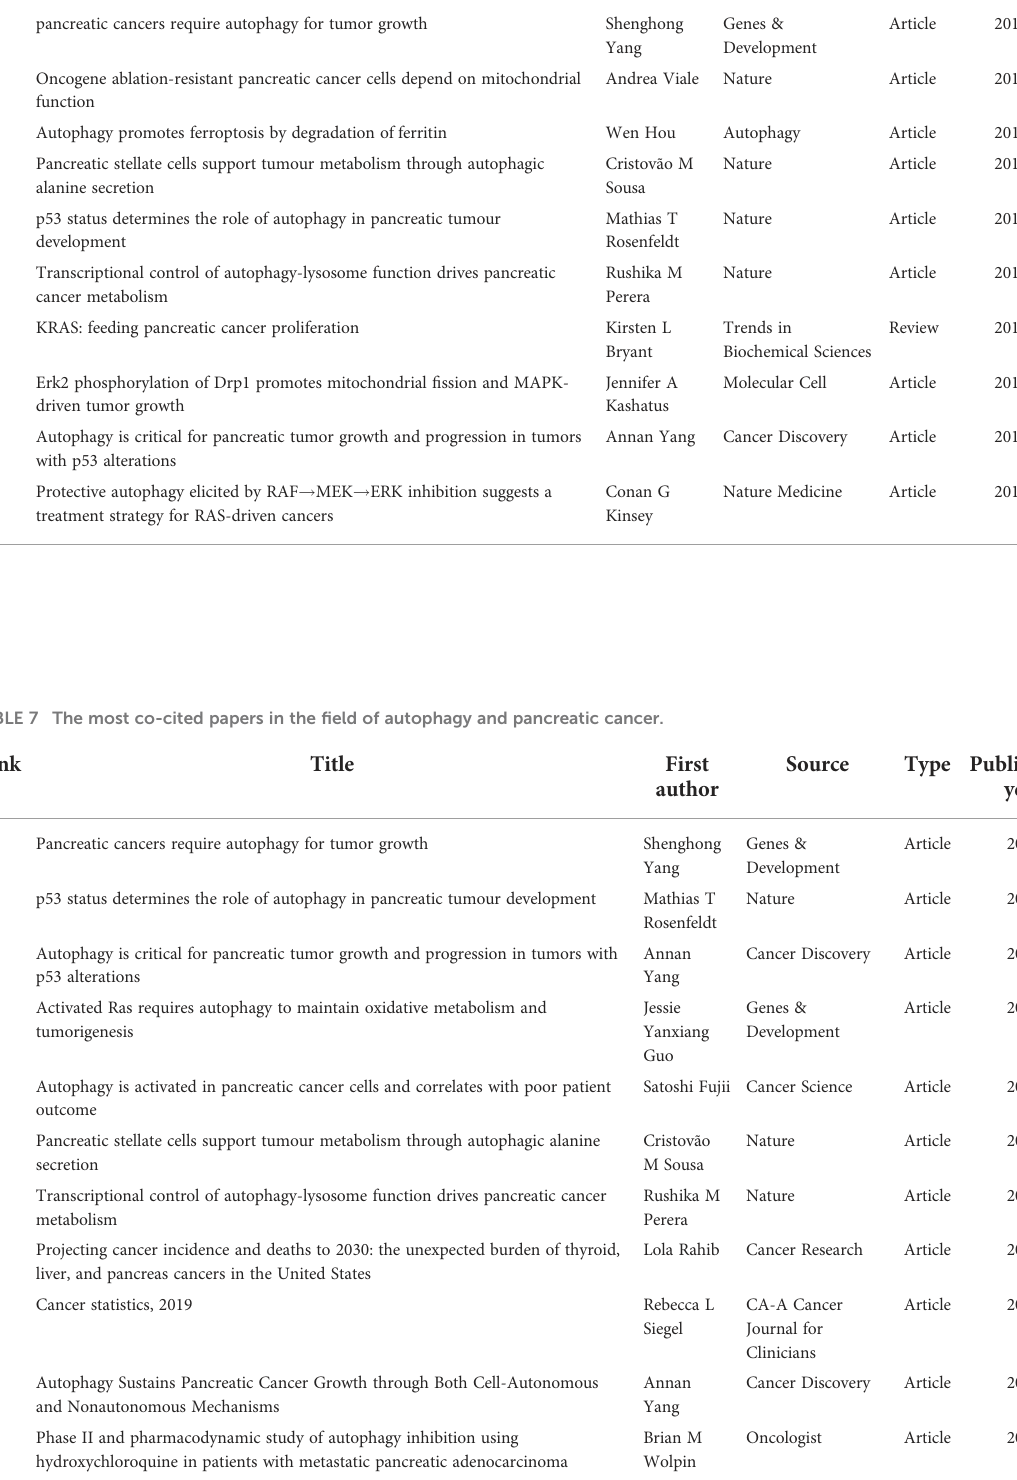
Autophagy Sustains Pancreatic Cancer Growth through Both Cell-Autonomous and Nonautonomous Mechanisms Phase II and pharmacodynamic study of autophagy inhibition using hydroxychloroquine in patients with metastatic pancreatic